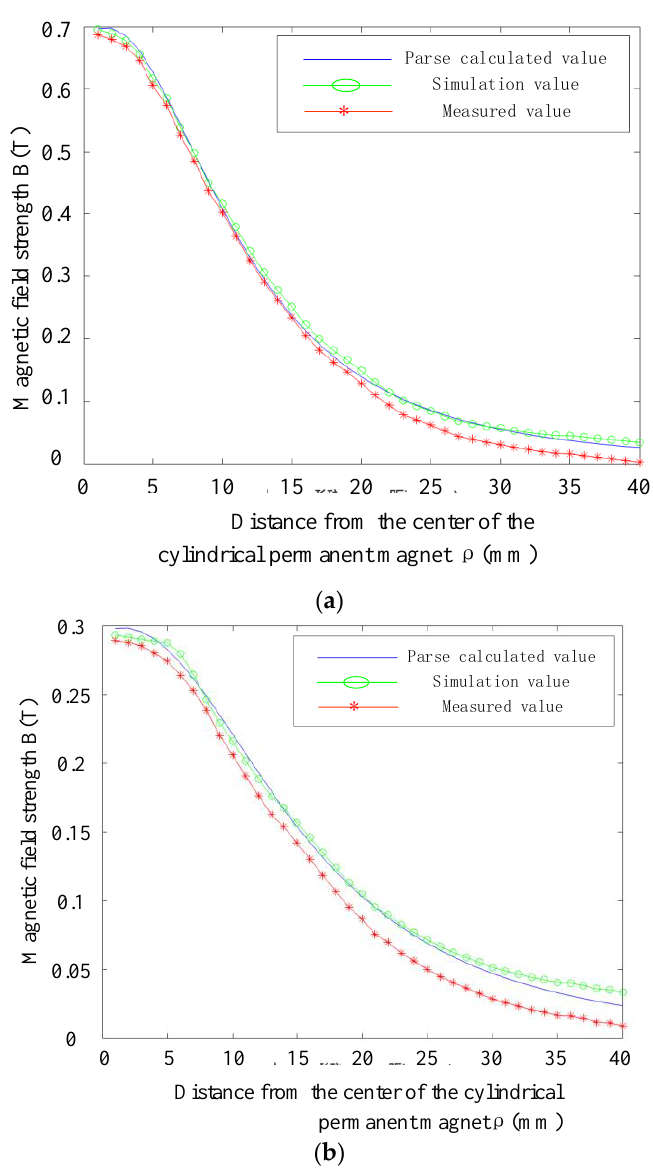
Figure 8. Comparison of the calculated value, simulated value, and measured value. ( a ) Magnetic field 10 mm away from the upper-end face. ( b ) Magnetic field 15 mm away from the upper-end face.